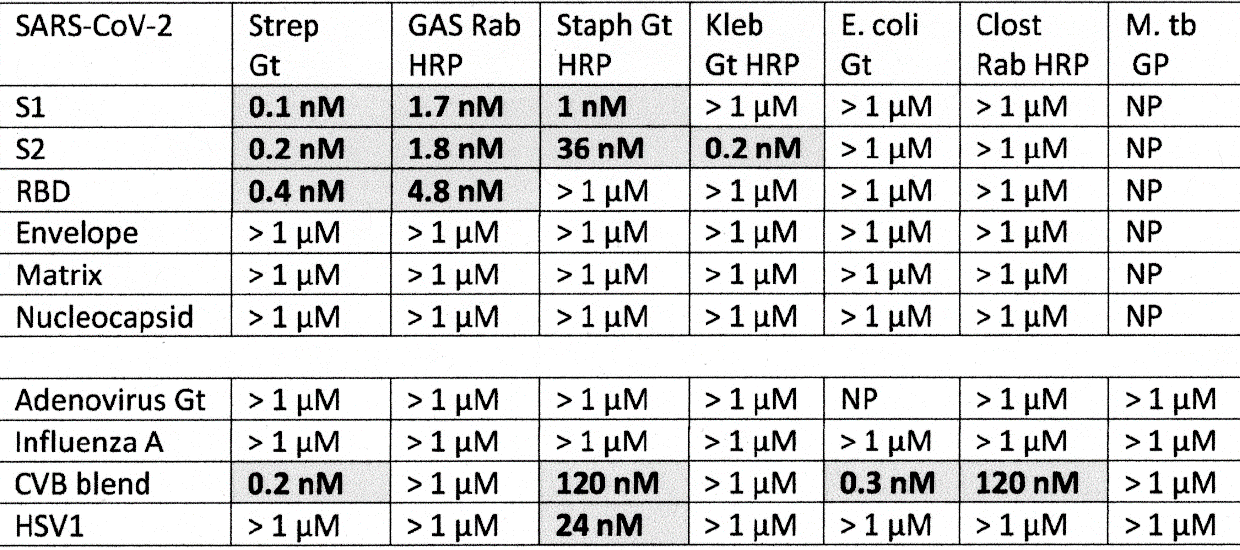
Figure 12. Results of DA-ELISA experiments testing for SARS-CoV-2 antibodies binding to Group A Streptococcus antibodies. Because both the virus and bacterial antibodies are polyclonal, multiple sets of complementary interactions are possible. Thus, while there is very clear evidence of binding